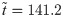
Test 2: Comparison between FOM and DL-ROM solutions for a testing-parameter instance.FOM solution (left), DL-ROM one (center) with n = 5, and relative error ϵk (right) at t˜=141.2 ms (top) and t˜=157.2 ms (bottom), for the testing-parameter instance μtest = 0.9625 cm. The relative error ϵk is below 0.1% at both time instants.